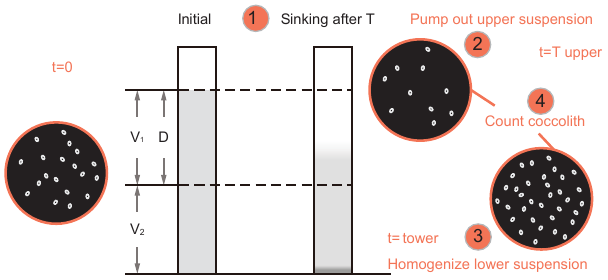
Figure 2. Schematic of settling experiments. V 1 and V 2 are the vol- umes of the upper and lower cylinders; D is the settled distance. The numbers in circles are same as the number of steps described in Sect. 2.2.1.